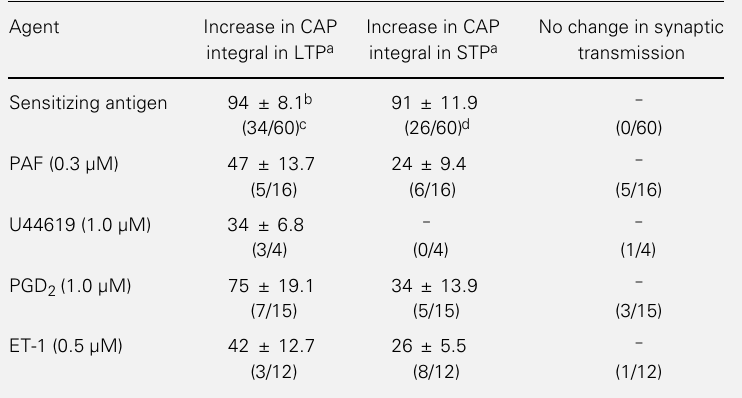
Table 1 - Effect of sensitizing antigen, platelet aggregating factor (PAF), U44619, prostaglandin